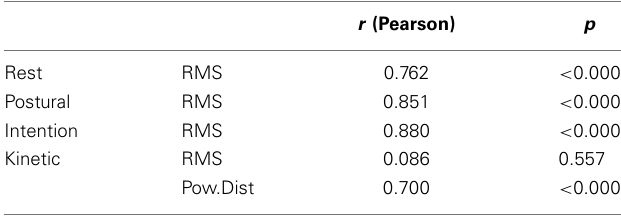
Table 4 | Correlation coefficients between the tremor amplitude (RMS) obtained from the algorithms imbedded within the smart phone and the clinical tremor scores.